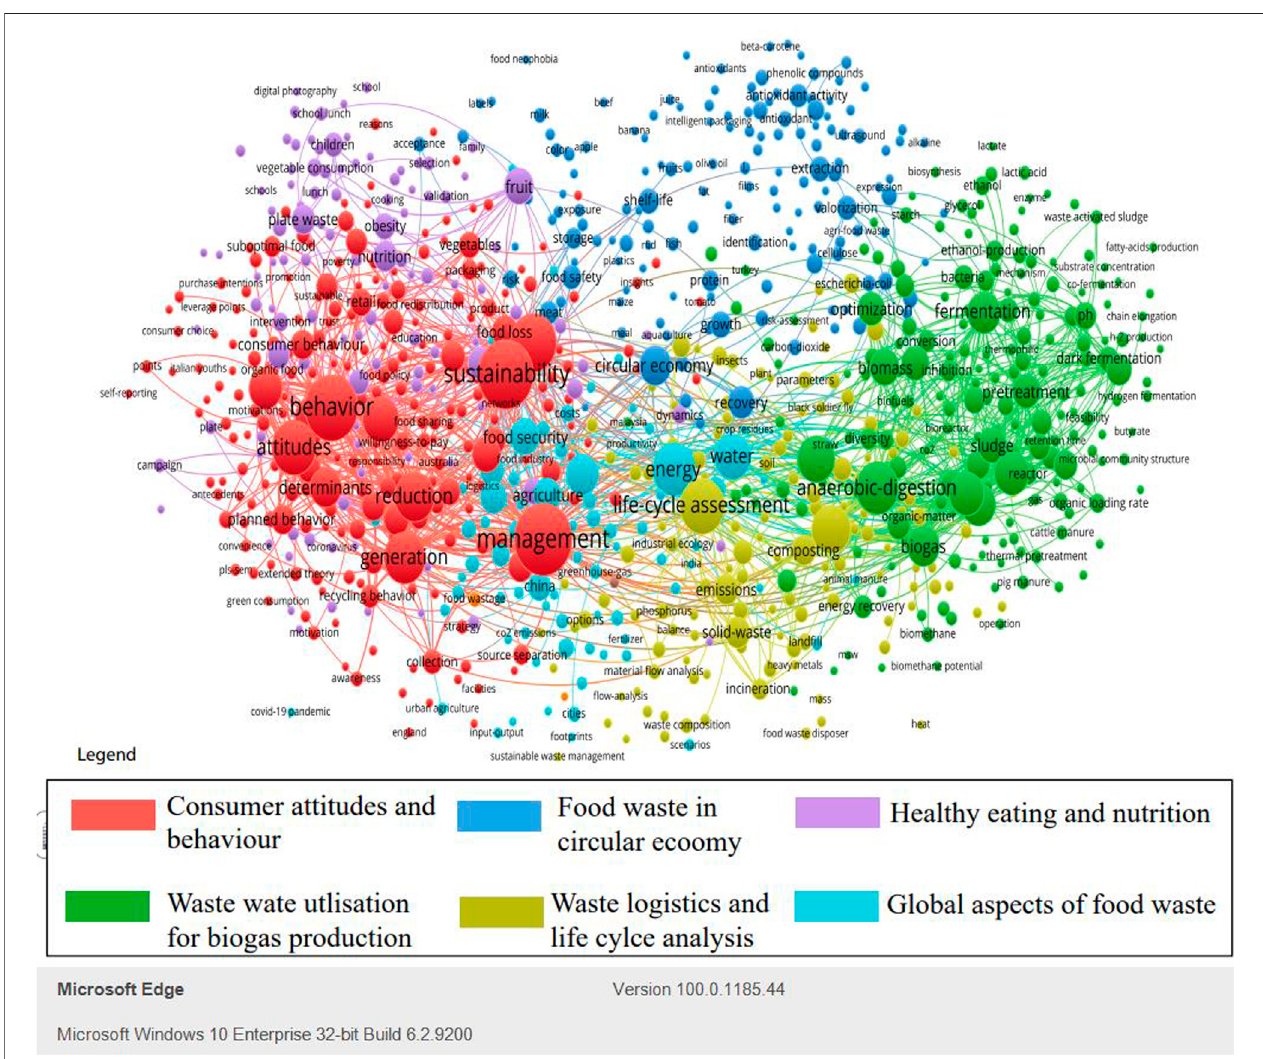
FIGURE 5 | The key topics of household waste research based on the co-occurrence of keywords.